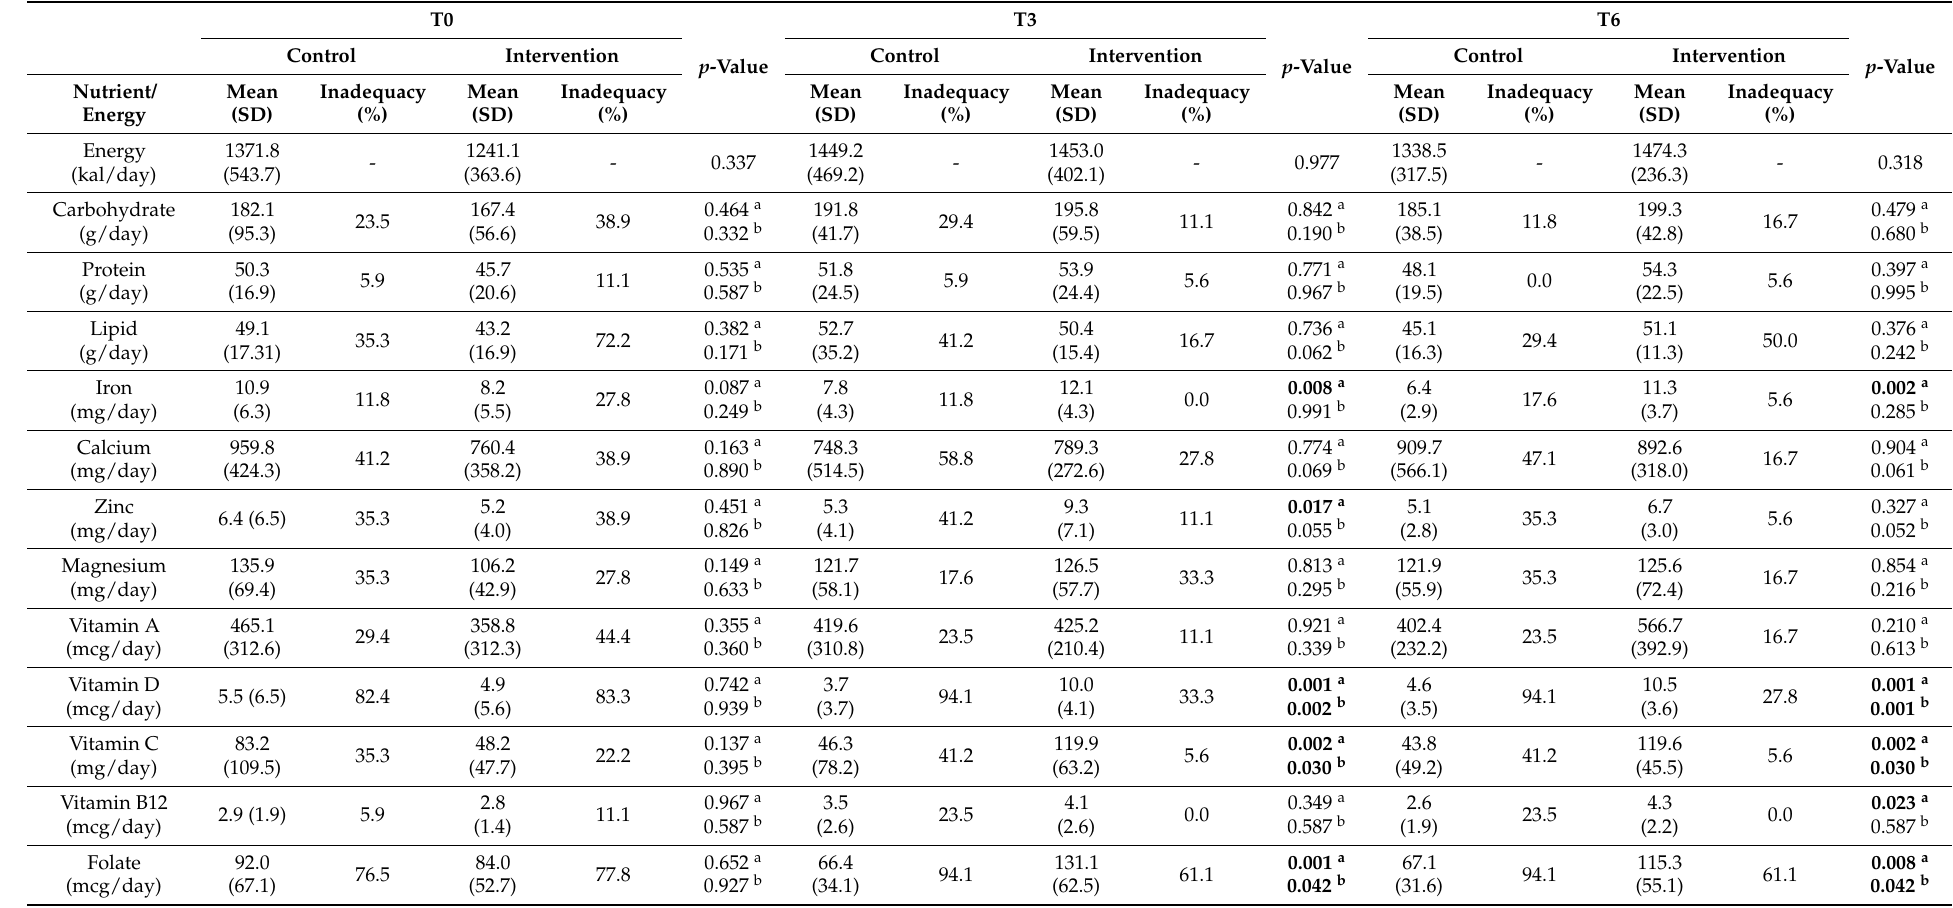
Table 3. Energy and nutrients intake and percentage of inadequate intake at times T0, T3 and